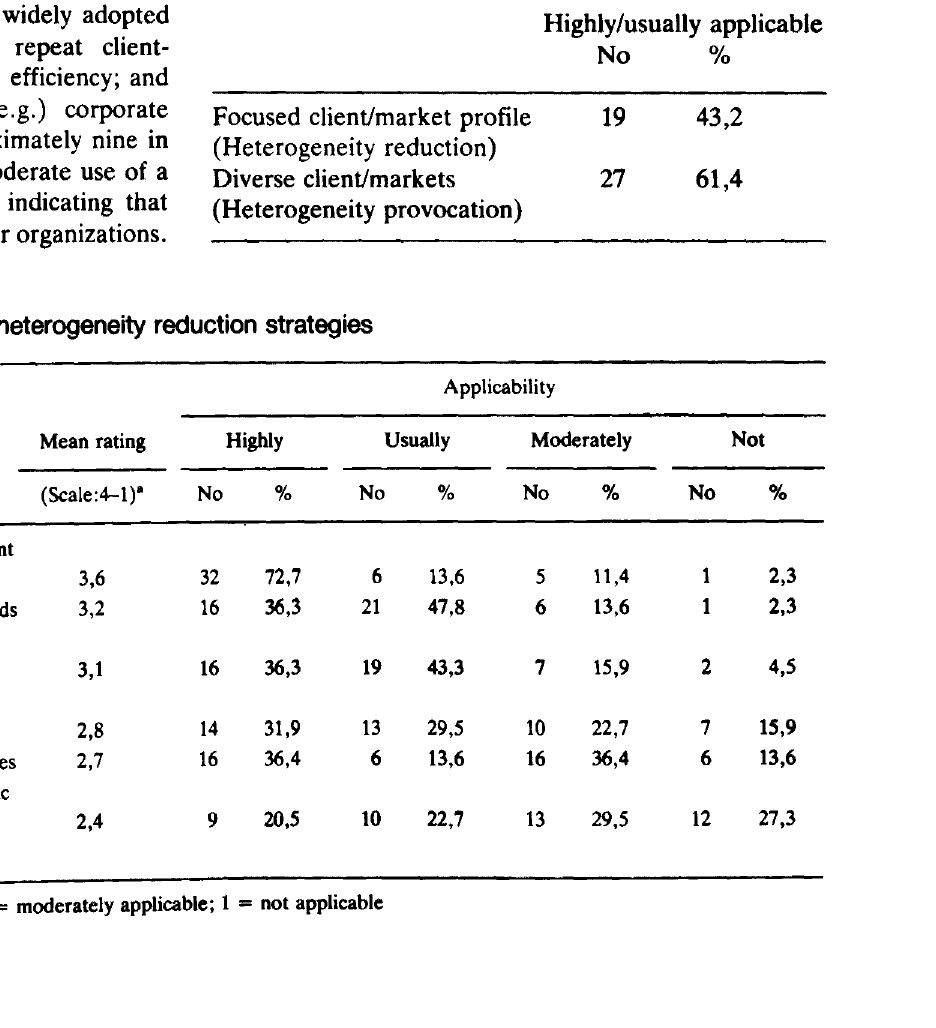
Table 4 Applicability of recommended heterogeneity reduction